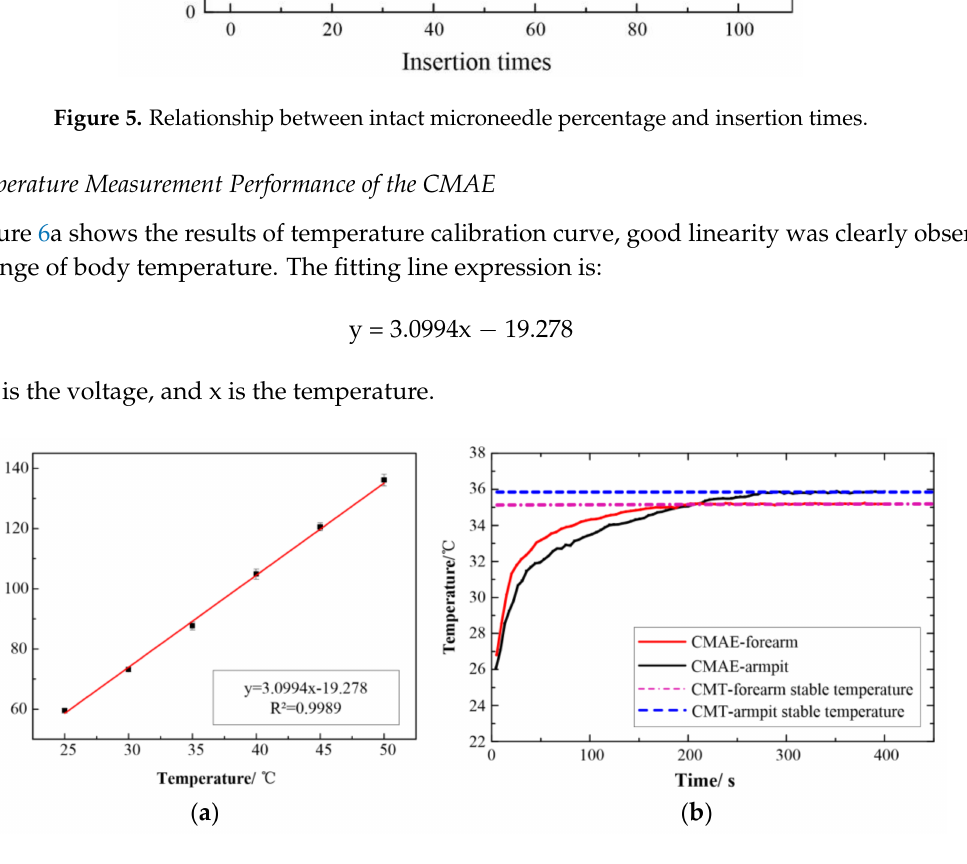
Figure 6. Temperature measurement performance of the CMAE ( a ) Temperature calibration curve; ( b ) Temperature measurement